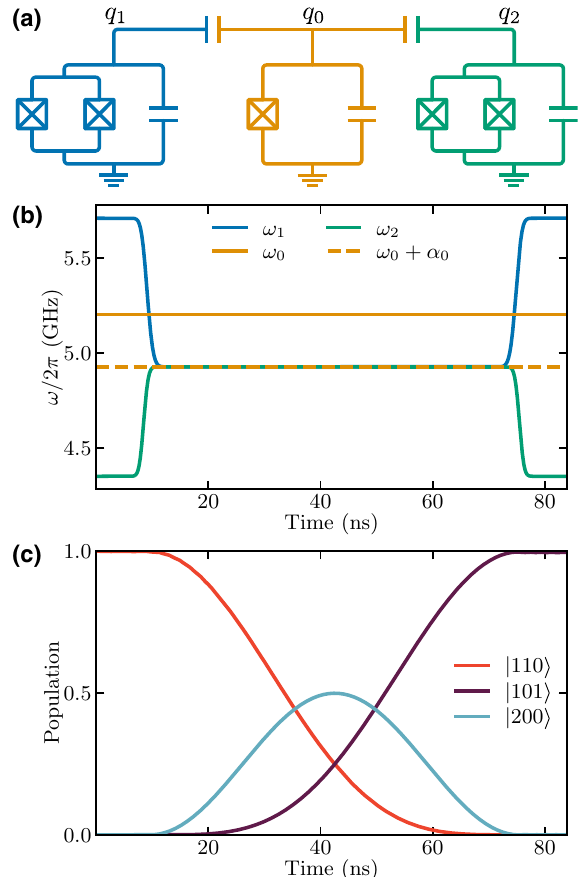
FIG. 7. Implementing a CCZS gate with tunable qubits. (a) A sketch of the setup, with qubit numbering following the con- vention established in Fig. 1(a). The superconducting qubits are transmon qubits [103], which are nonlinear LC oscillators where the nonlinear inductances are provided by Josephson junc- tions (boxes with crosses in the sketch). When two Josephson junctions are combined in a loop [a superconducting quantum interference device (SQUID)], the effective inductance, and thus the qubit frequency, can be tuned by controlling the magnetic flux through the loop. (b) The tuning of the qubit energies used to implement a high-fidelity CCZS (π/ 2, π , 0 ) gate. (c) Population of the states | 110 (cid:2) , | 200 (cid:2) , and | 101 (cid:2) during the CCZS (π/ 2, π , 0 ) gate when the initial state is | 110 (cid:2) . As Eq. (24) shows, the main effect of this gate is to swap the population between qubits 1 and 2 if qubit 0 is in its excited state. √ The factor and λ to 2 appears in Eq. (48) since we use λ 1 2 denote the coupling strengths for | 11 (cid:2) ↔ | 20 (cid:2) transitions instead of the coupling strengths for | 10 (cid:2) ↔ | 01 (cid:2) transi- tions, which are the parameters that are actually given as input to the simulation. To activate the gate, energies ω and ω of qubits 1 1 2 + α , as shown in and 2 are tuned into resonance with ω 0 0 Fig. 7(b). To account for the finite response time of the drive line, the pulse used for tuning the qubit energies is